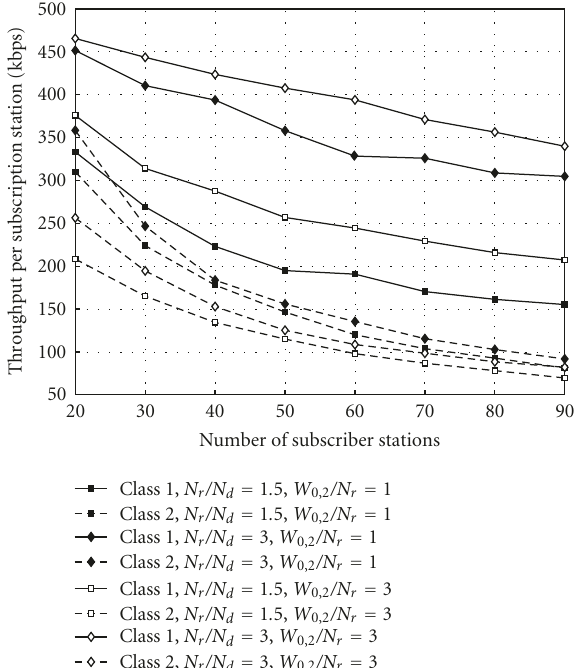
Figure 10: Throughput of single SS versus the number of SSs with absolute bandwidth allocation priority, and di ff erentiated channel access parameters: W 0,1 = W 0,2 = N r , W x ,1 = 2 4 W 0,1 and W x ,2 = 2 8 W 0,2 .